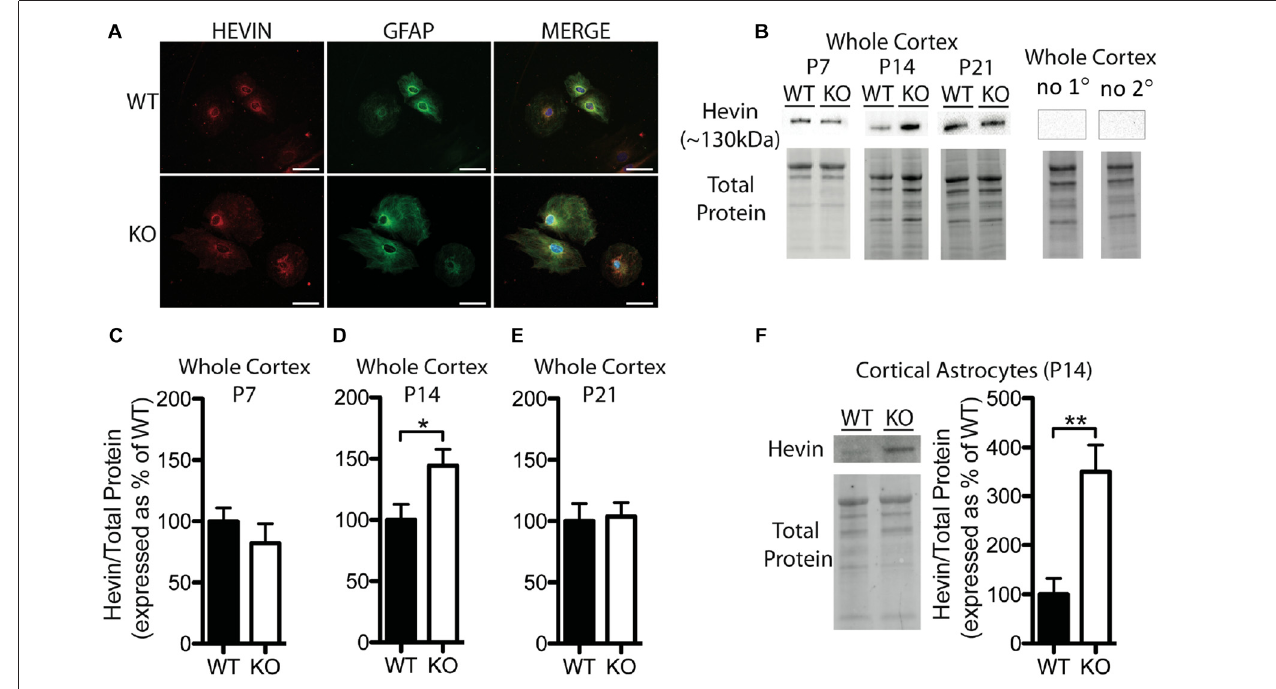
FIGURE 2 | Hevin expression is altered at postnatal day (P) 14 in the cortex of Fmr1 knock-out (KO) mice. (A) Cultured cortical astrocytes co-labeled with anti-glial fibrillary acidic protein (GFAP; green) and anti-hevin (red) after 2 days in vitro . Nuclei were stained with 4 (cid:48) ,6-diamidino-2-phenylindole (blue). Images were obtained using a 40x objective with a Zeiss Axioimager M2. Scale bars = 50 µ m. (B) Representative western blots showing hevin ( ∼ 130 kDa) in cortical samples (30 µ g of protein per lane) from P7, P14 and P21 WT and Fmr1 KO mice, as well as the corresponding total protein within each lane. Negative controls that were run using P14 WT whole cortical tissue with either no primary antibody or no secondary antibody are shown. (C–E) Hevin expression in the cortex of WT (black; n = 8) and Fmr1 KO (white; n = 8) mice at P7, P14 and P21. Bands representing hevin were normalized against the total protein within the same lane on the membrane, and were then expressed as a percent of the average level of hevin in the WT group. (F) Hevin expression in cortical astrocytes isolated from P14 WT (black; n = 4) and Fmr1 KO (white; n = 4) mice. Immediately to the left of the graph is shown a representative Western blot with bands corresponding to hevin from P14 WT and Fmr1 KO cortical astrocyte samples (10 µ g of protein per lane), as well as the corresponding total protein. Statistical differences were denoted with either a single asterisk, P < 0.05, or a double asterisks, P < 0.01.